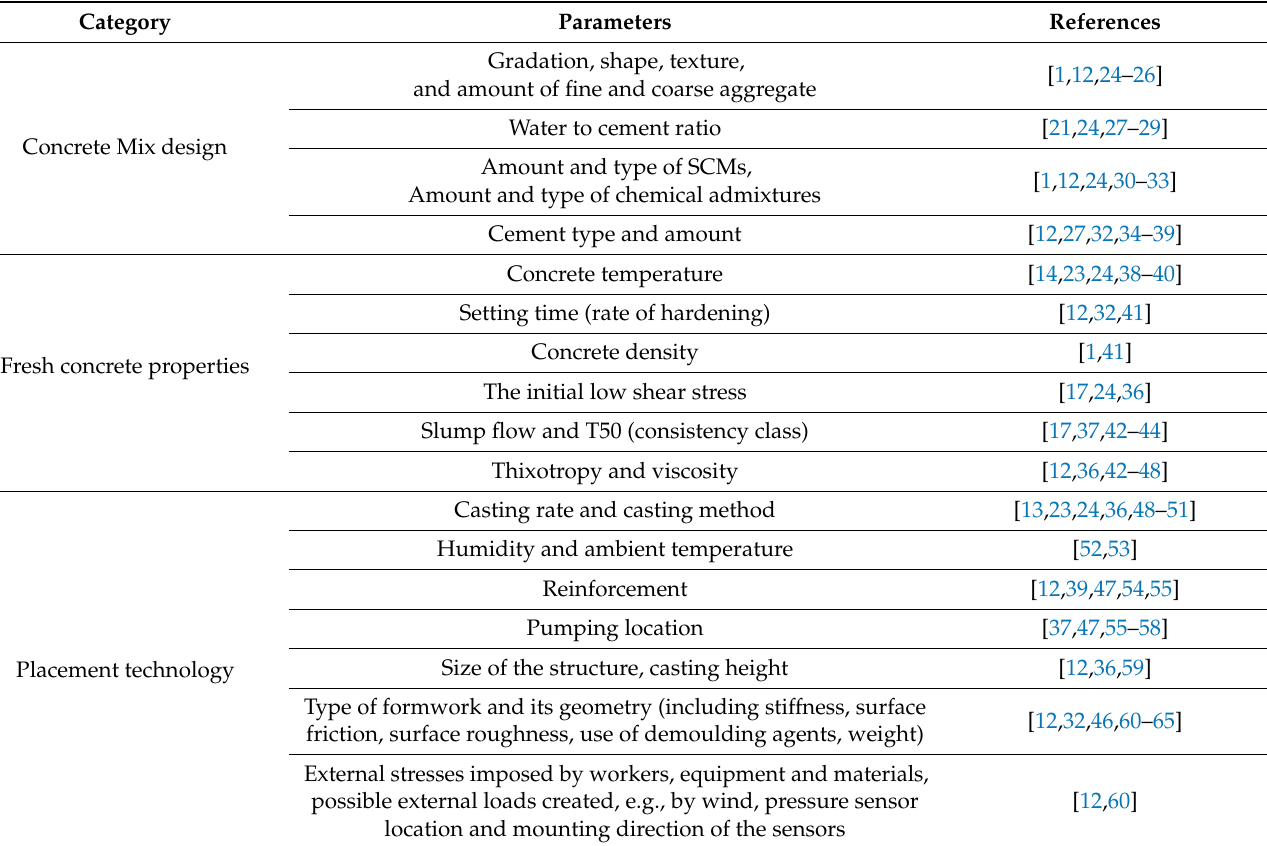
Table 1. Factors Affecting Lateral Form Pressure Exerted by